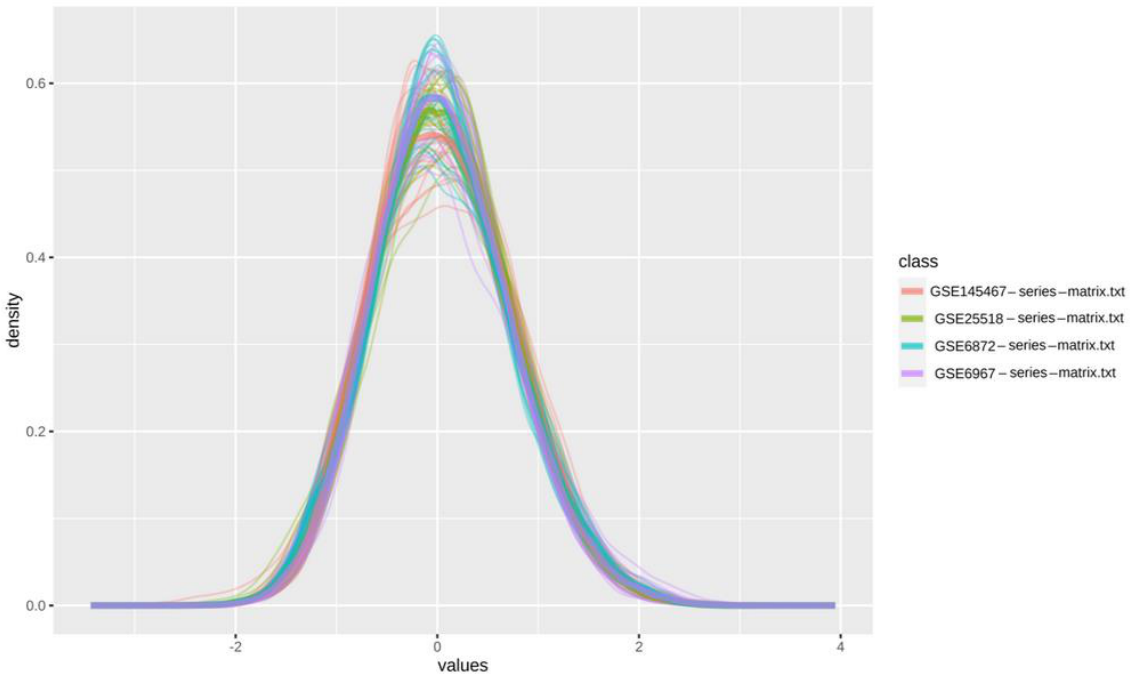
Figure 2. Density plot of the four datasets for teratozoospermia and azoospermia. GSE145467, GSE25518, GSE6872, and GSE6967 have been shown in pink, green, sky, and purple colors, respec- tively.